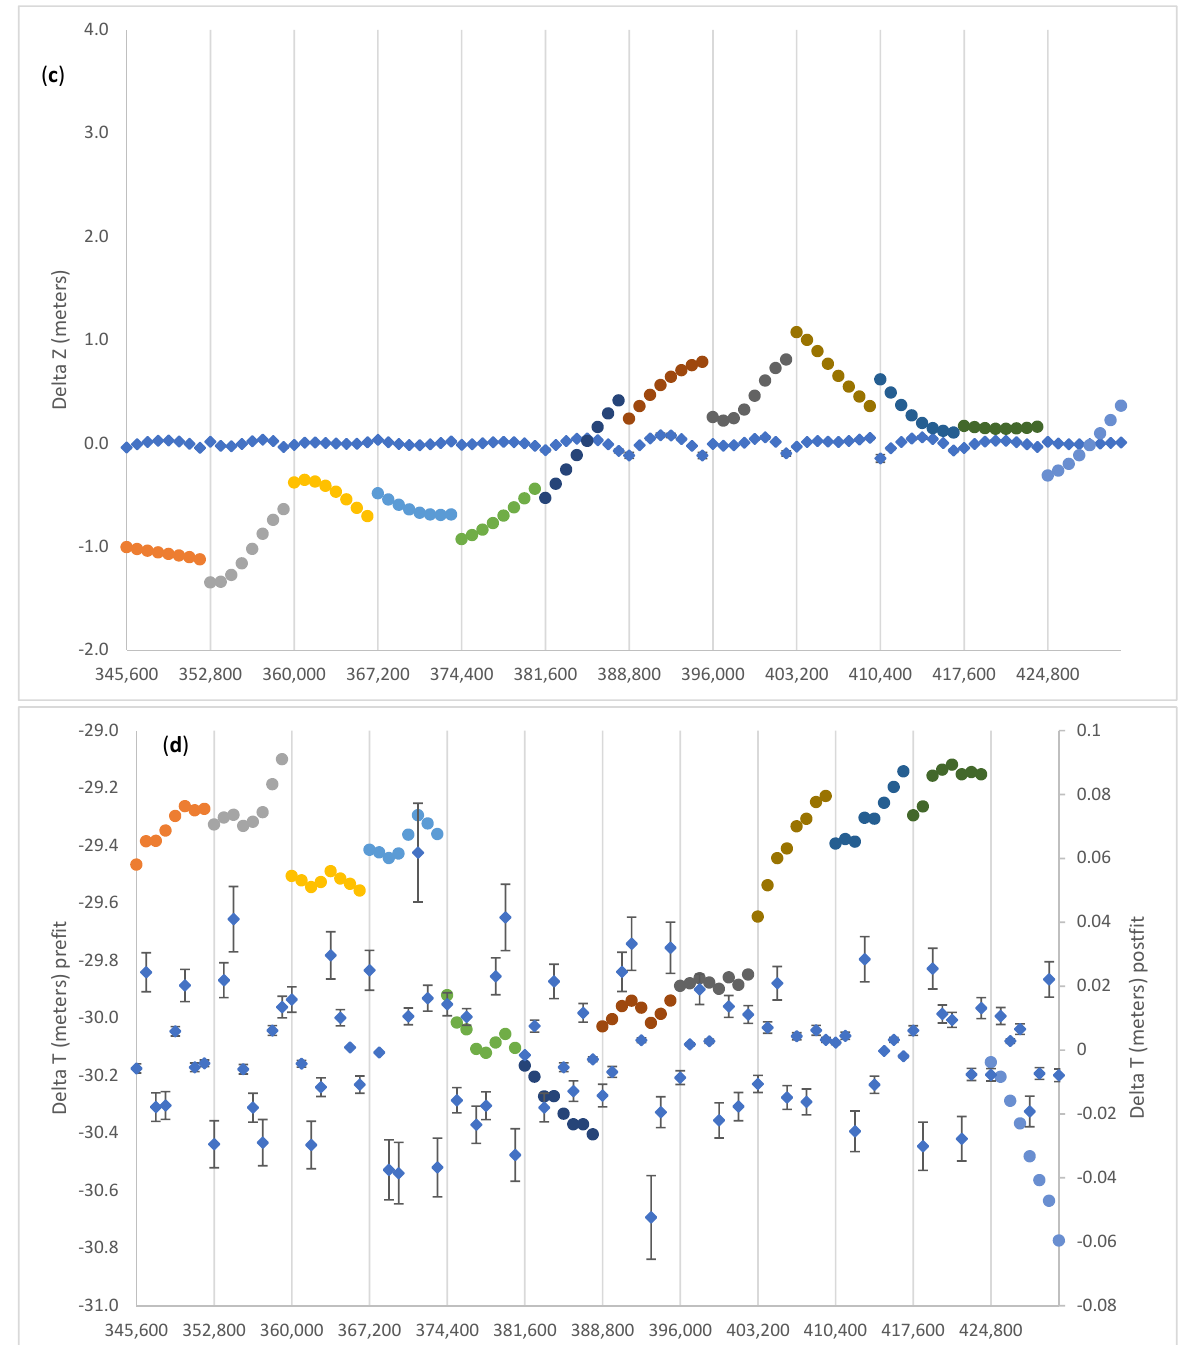
Figure 6. Pre-fit (dots, different colours refer to different ephemeris blocks) and post-fit (diamonds) residuals of ( a ) X, ( b ) Y, ( c ) Z for C07. For T (plot ( d )) pre-fit (dots) refer to the left y-axis and post-fit (diamonds) to the right y-axis.